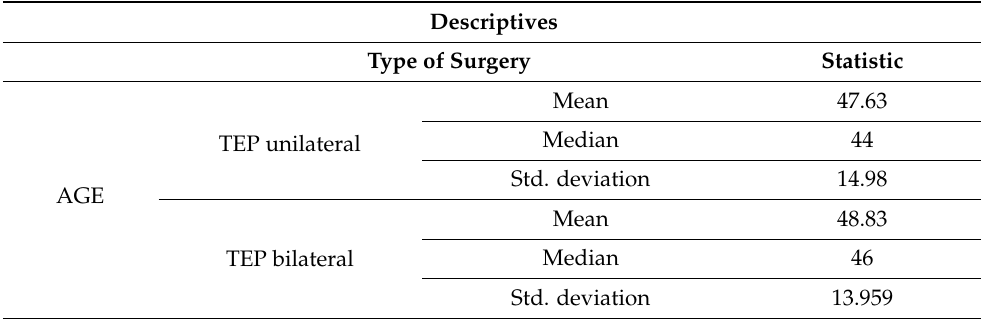
Table 2. The average age of the patients according to the type of operation performed.